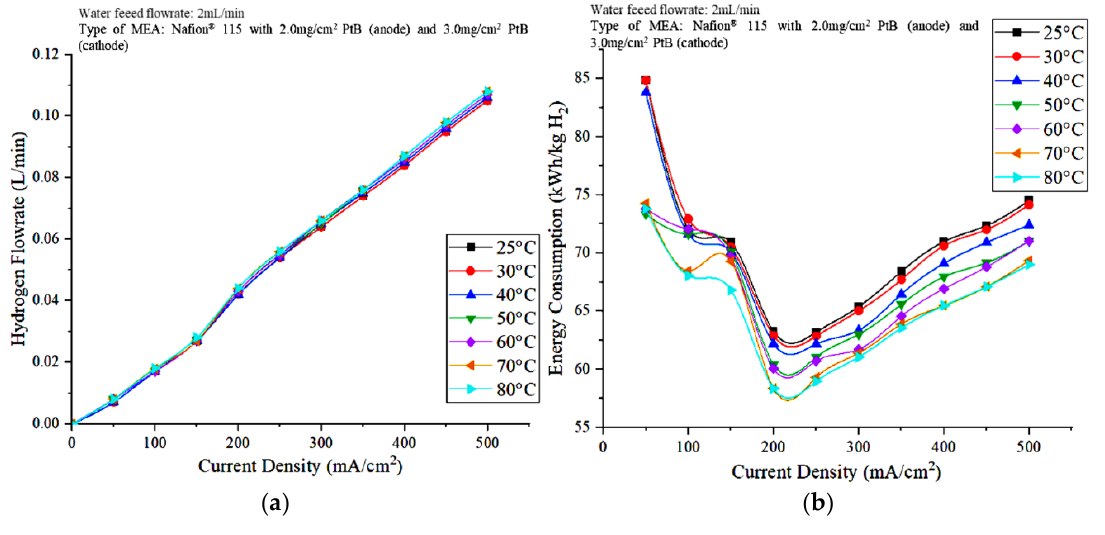
Figure 8. Effects of the operating temperature on the ( a ) hydrogen production and ( b ) energy consumption of the PEM electrolyzer.